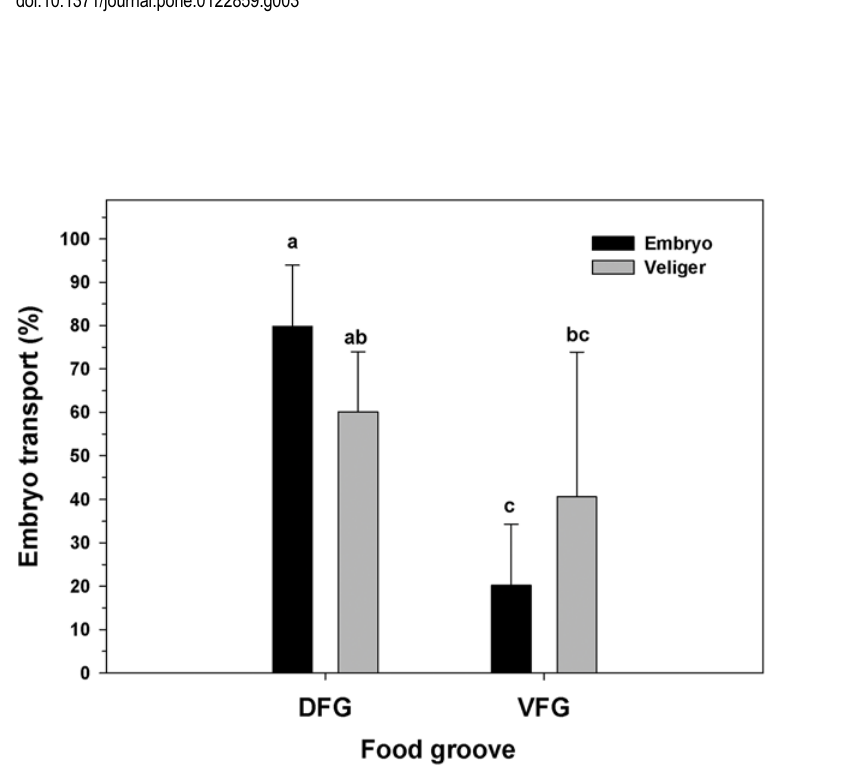
Fig 4. Ostrea chilensis. Utilization of female oyster ciliated grooves to transport embryo or veligers. DFG: Dorsal food groove; VFG: Ventral food groove. Different letters above the bars indicate significant differences (p < 0.05); mean + SD shown.